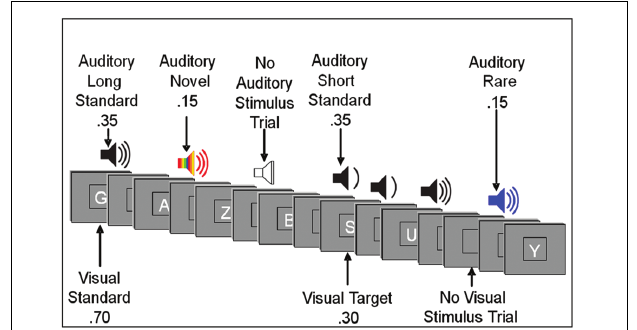
FIGURE 1 | Illustration of an experimental run. Subjects responded to visual target letters (forced choice) while instructed to ignore auditory stimuli. Visual stimuli were presented for 200 ms. Auditory standard and rare stimuli were presented for 250 ms or 125 ms; auditory novel stimuli were presented for 250 ms. The interstimulus interval varied randomly between 315 and 665 ms. (See text for more details.).